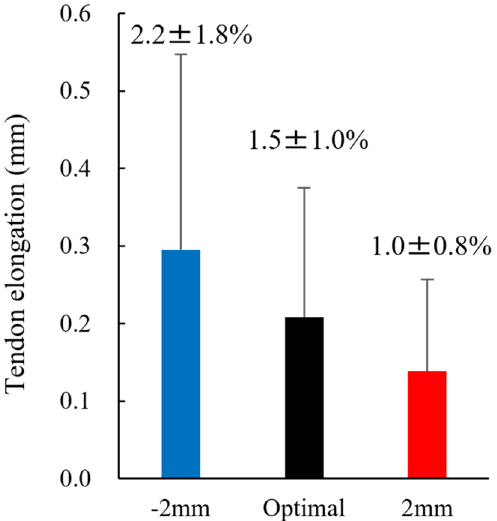
Figure 5. Comparison of the tendon elongation attained among − 2 mm, optimal, and 2 mm conditions (N = 9) (means ± SD). The values of strain (the magnitude of tendon elongation with respect to the entire tendon length, means ± SD) were added in the bar graph.